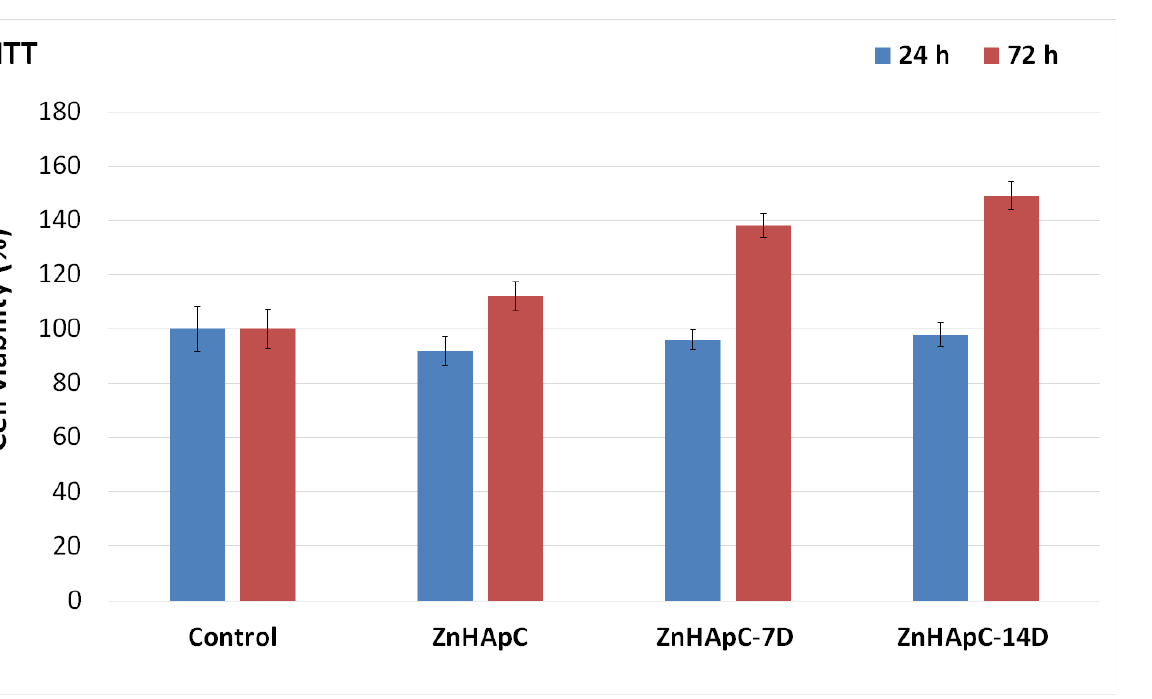
Figure 7. Cell viability of the hFOB 1.19 cells after 24 and 72 h of incubation in the presence of ZnHApC, ZnHApC-7D, and ZnHApC-14D. The results of the experiments are graphically represented as mean ± SD. The data were statistically analyzed using paired and two-sample t-tests for means, with p ≤ 0.05 accepted as statistically significant.